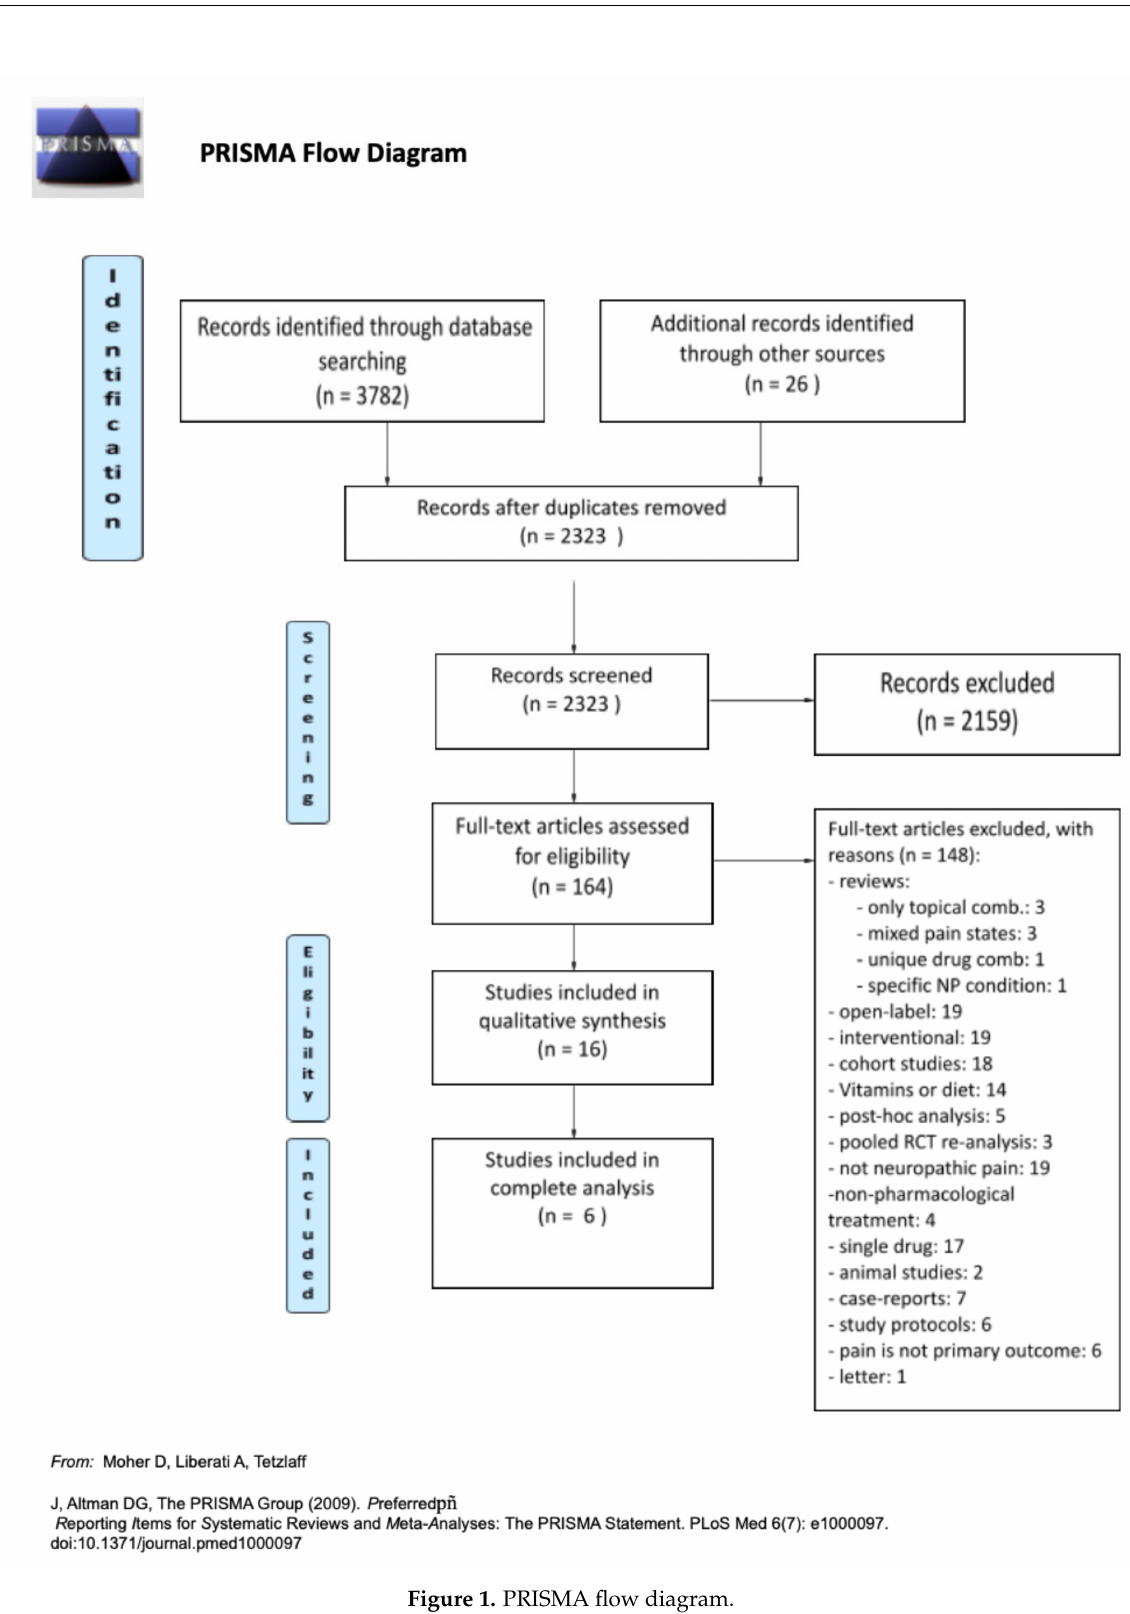
Figure 1. PRISMA flow